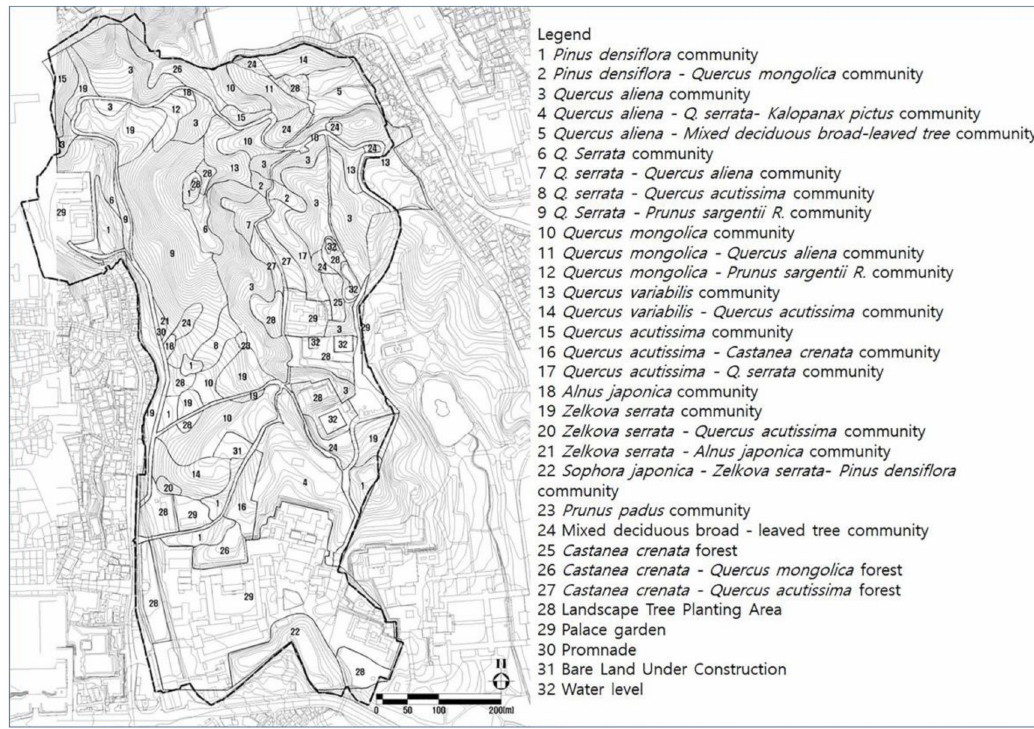
Figure 2. Actual vegetation map of the forest of the Changdeokgung Rear Garden (Year: 2018).